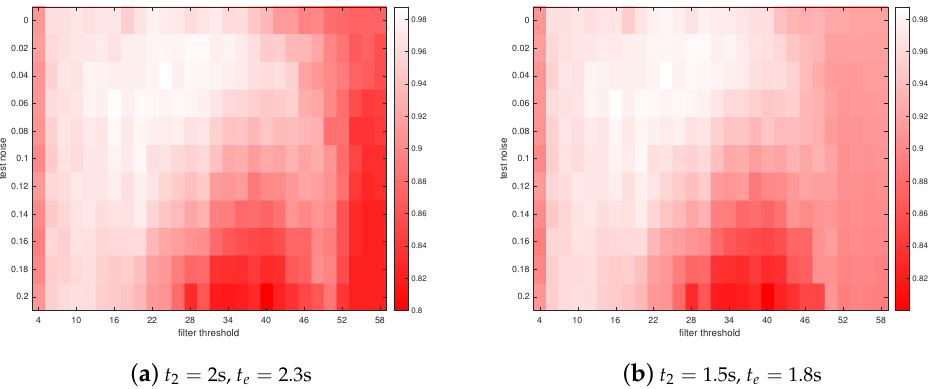
Figure 11. The performance score C p with different starting time t 2 with l = 8. In each sub-figure, the vertical axis denotes various levels of the salt-and-pepper noise at the testing stage. The horizontal axis denotes the threshold f 0 (increased by 2 units) of the low-pass filter. The right-end of ( a ) is darker than ( b ) and the remaining regions are nearly the